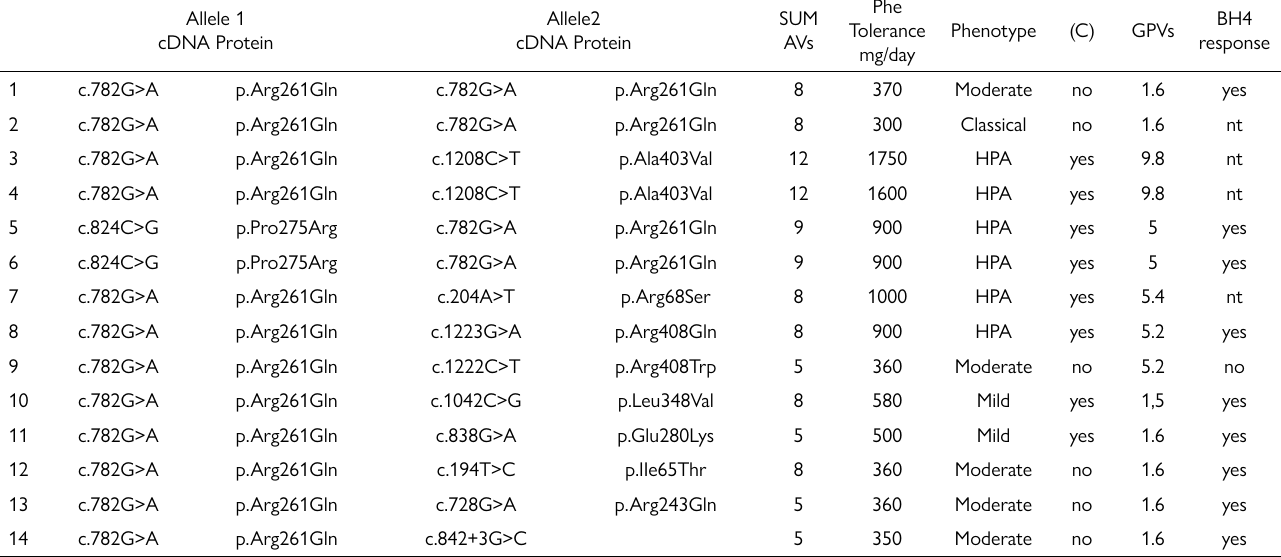
Table 1. Genotype (cDNA and protein) , SUM AVs, Phe tolerance(mg/day) , Phenotype, concordance (C), GPVs and BH4 response in the 103 studied